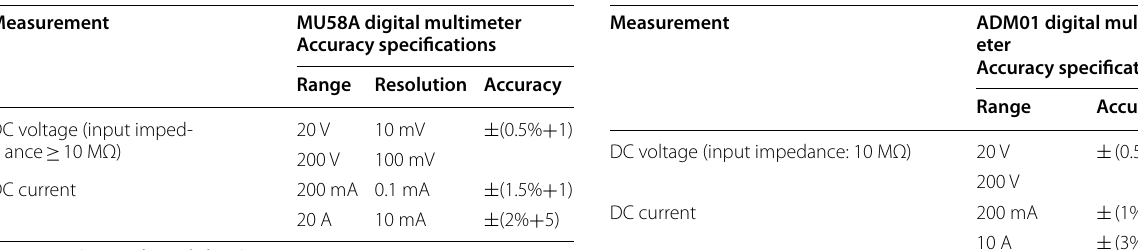
Table 6 Accuracy specifications of MU58A digital multim- Table 7 Accuracy specifications of ADM01 digital